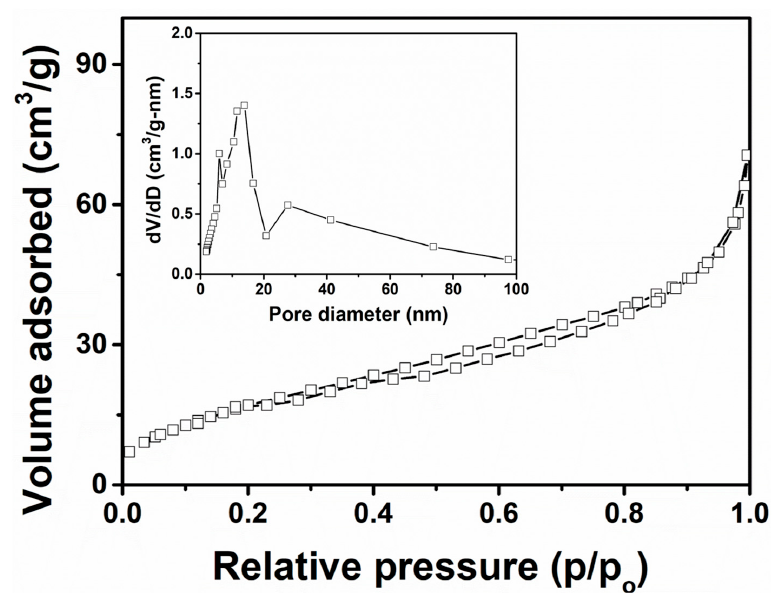
Figure 6. Nitrogen adsorption–desorption isotherms and pore-size distributions (inset) of as-synthesized TiO 2 nanoflowers.